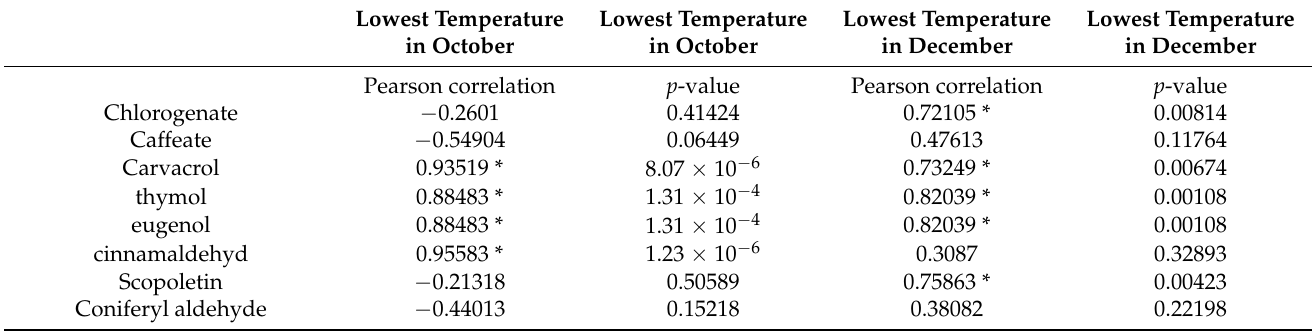
Table 2. Correlations between aromatic substances and two environmental